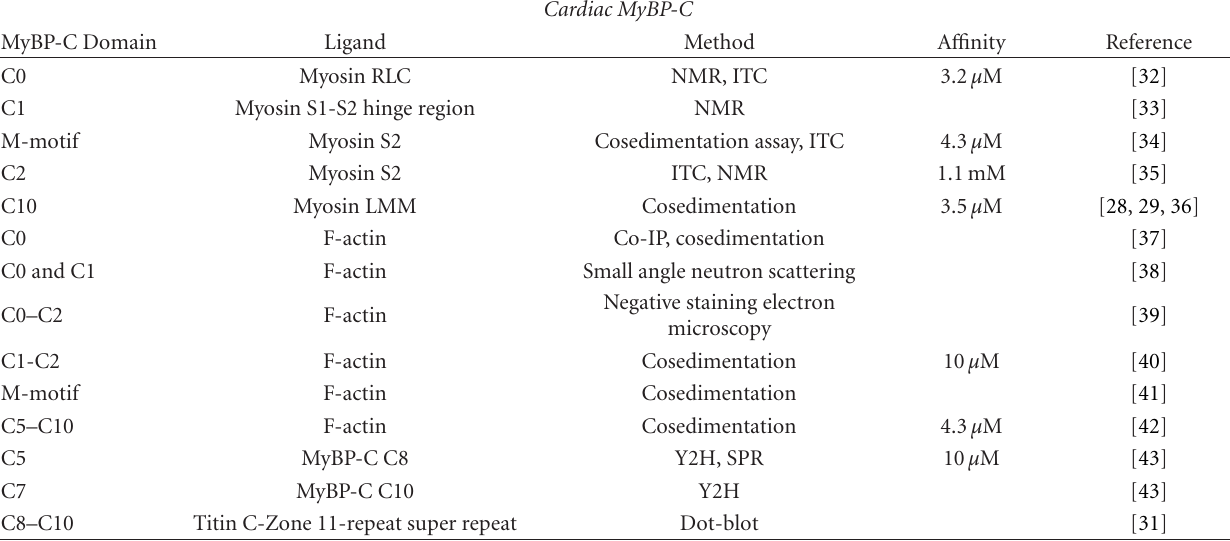
Table 1: Ligands of the cardiac isoform of MyBP-C.